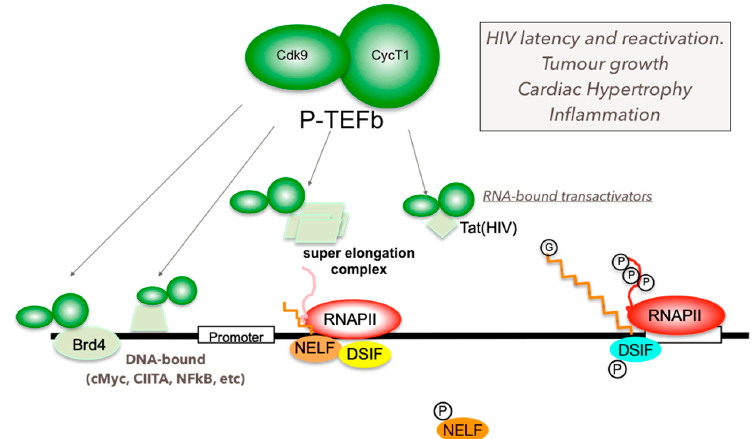
Figure 3. P-TEFb (CycT1:CDK9) is recruited to the RNAPII transcription machinery by various factors such as the epigenetic factor Brd4, DNA-bound transactivators, RNA-bound transactivtors, or Super Elongation Complexes. Aberrant regulation of P-TEFb functions causes various diseases and conditions including HIV latency / reactivation, inflammation, tumor growth and cardiac hypertrophy.